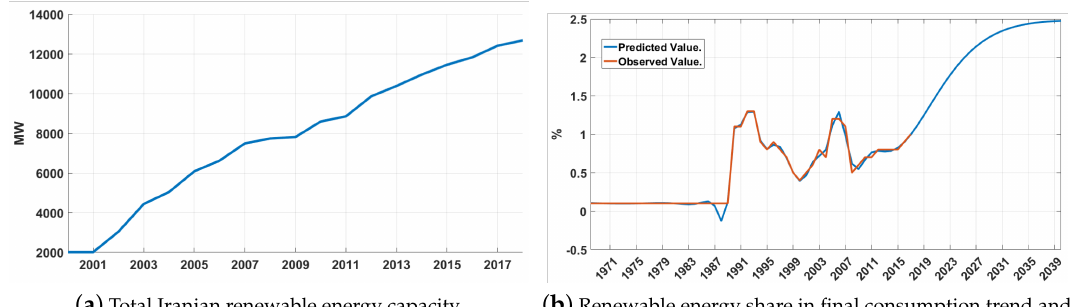
Figure 8. Iranian RESH prediction and RE capacity